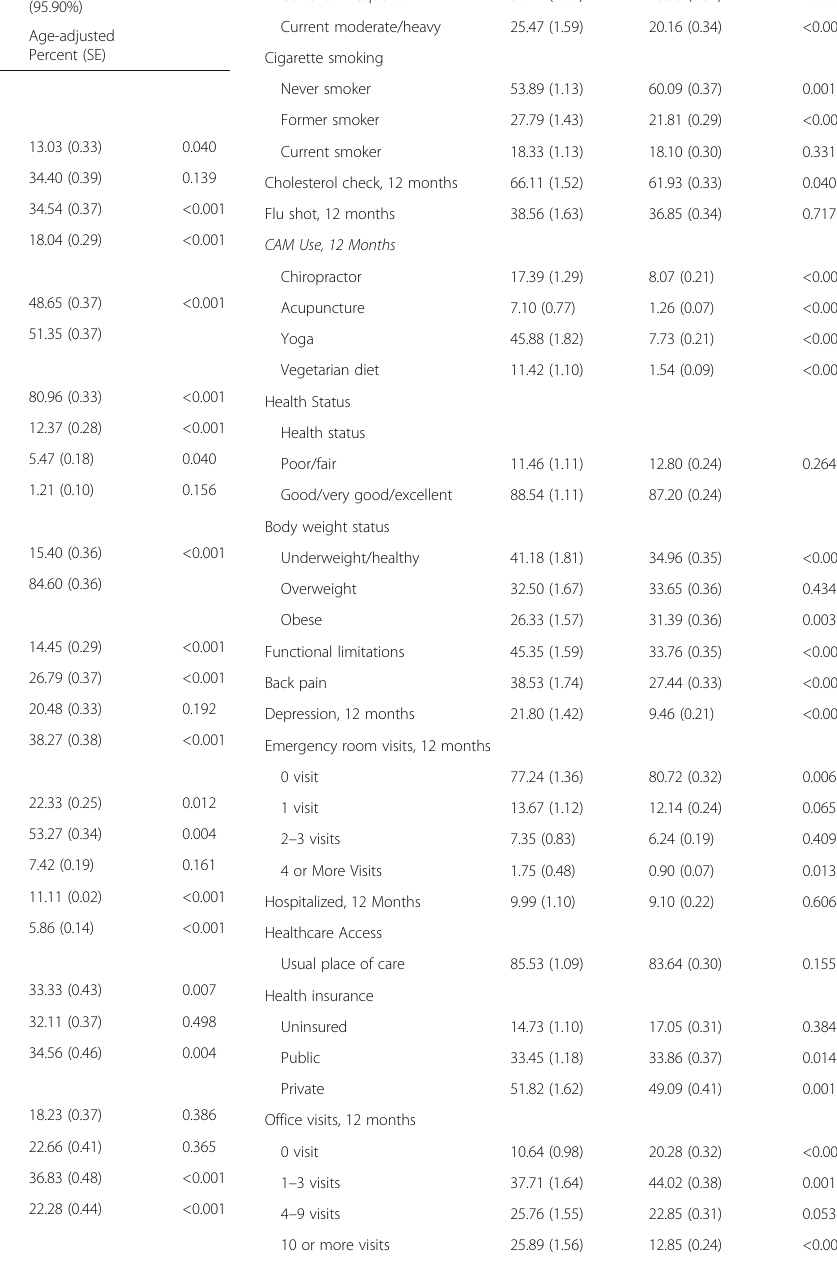
Table 1 Comparison of meditators and non-meditators by select user characteristics, use during the previous 12